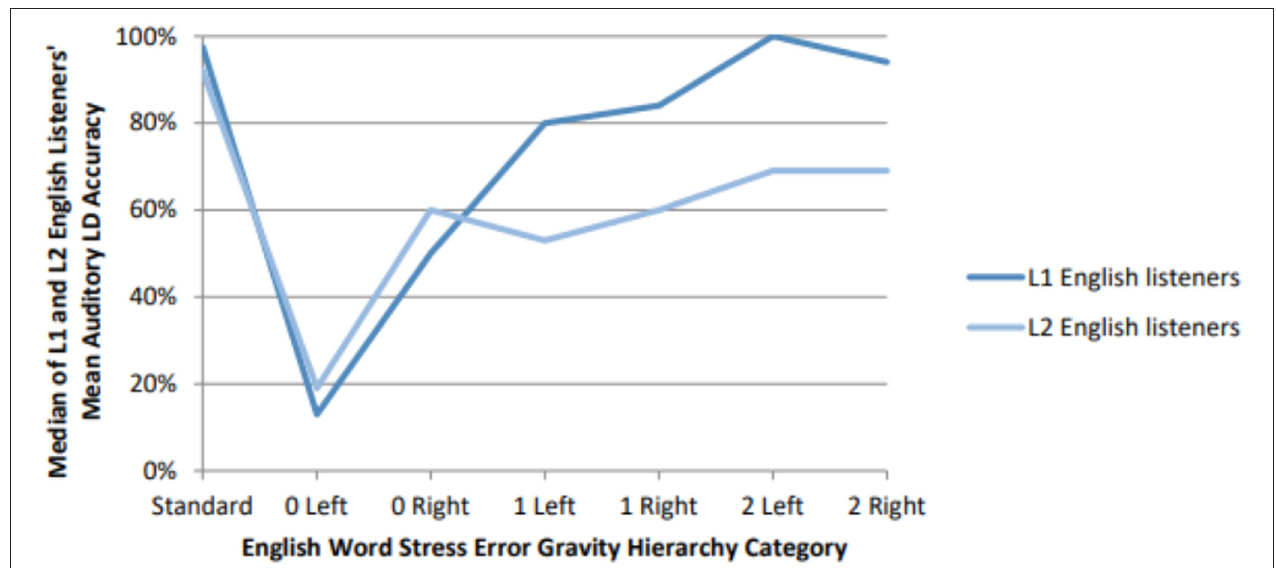
FIGURE 5 | Median of L1 ( n = 38) and L2 ( n = 31) English listeners’ mean auditory LD accuracy by Hierarchy category.